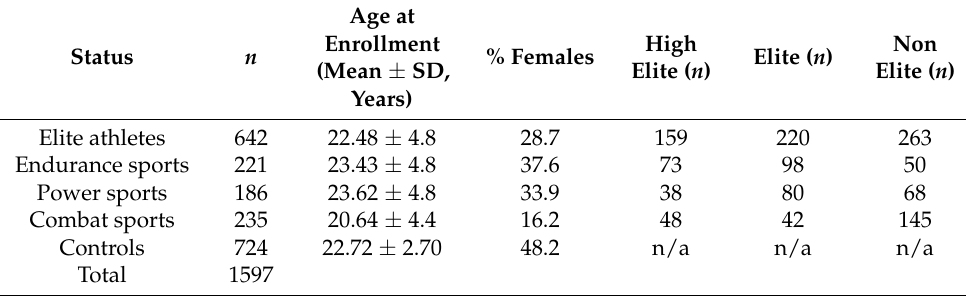
Table 1. Study group structure.